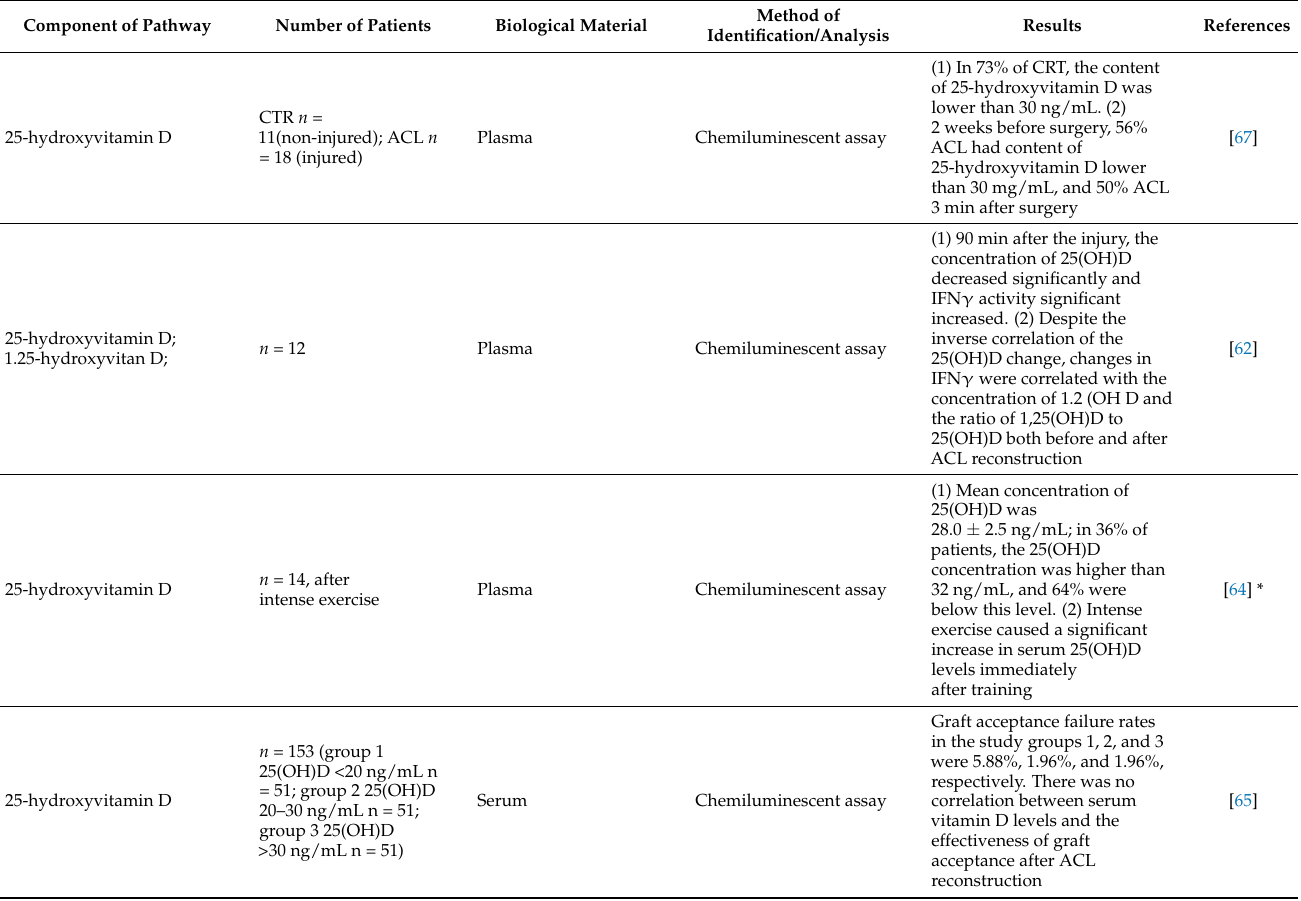
Table 3. Characteristics of the vitamin D metabolic pathway components in anterior cruciate ligament